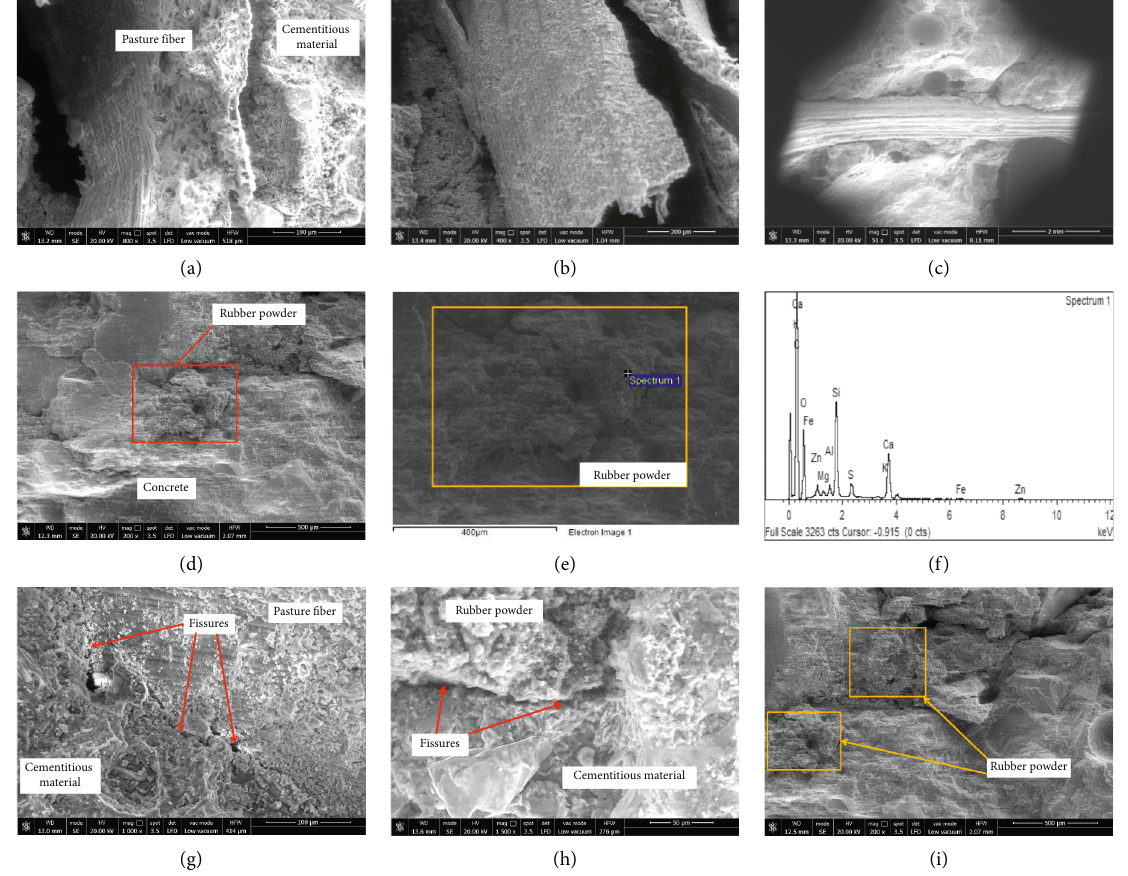
Figure 10: Scanning electron microscopy photos and elemental energy spectrum curve. (a) Pasture fiber and cementitious material. (b) Pasture fiber. (c) Pasture fiber and concrete. (d) Rubber powder and concrete. (e) Test point location of energy spectrum test. (f) The elemental energy spectrum curve. (g) Pasture fiber and fissures. (h) Rubber powder and fissures. (i) Rubber